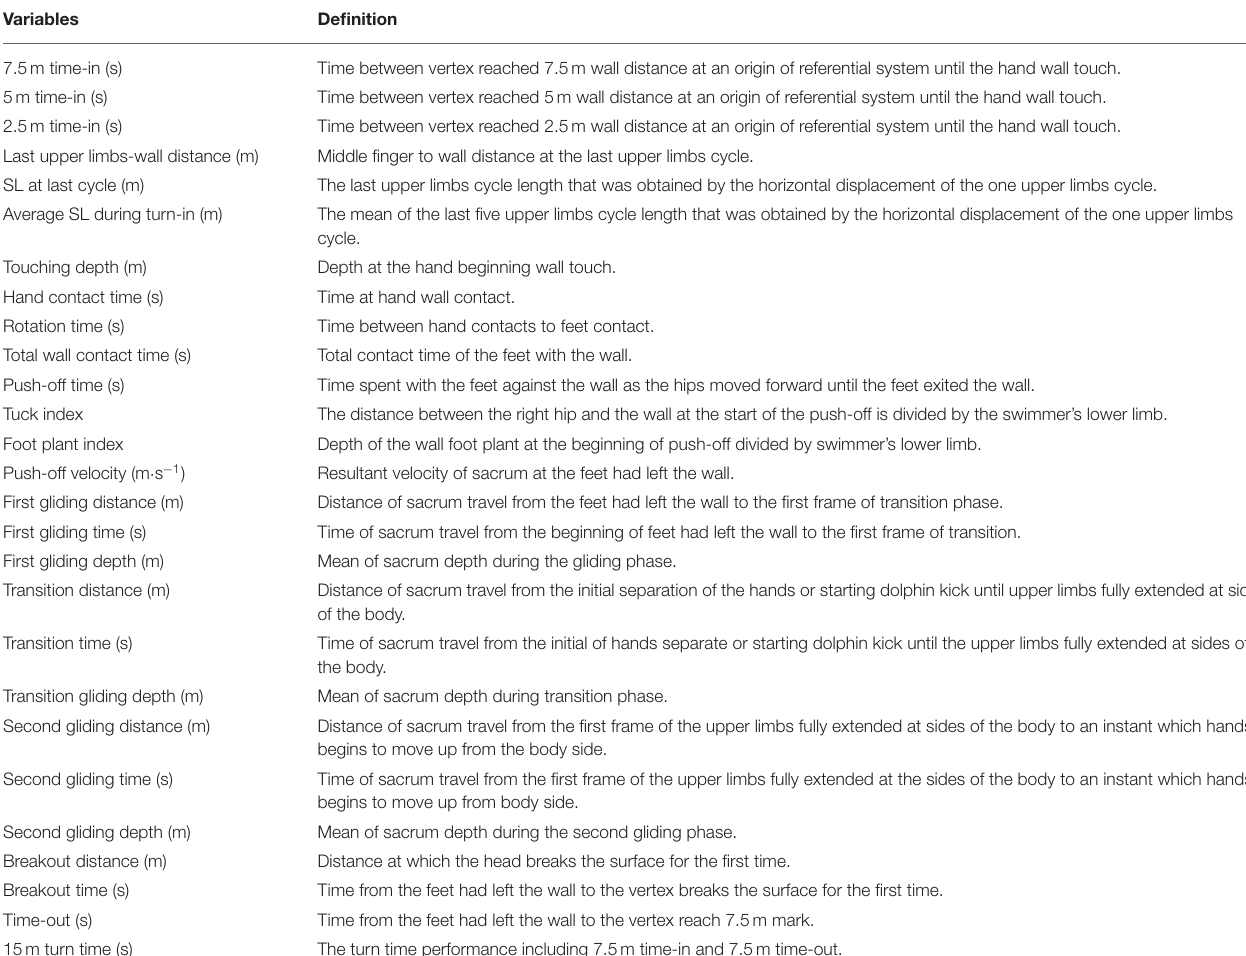
TABLE 1 | Kinematic-temporal variables selected for studying backstroke to breaststroke turning techniques.